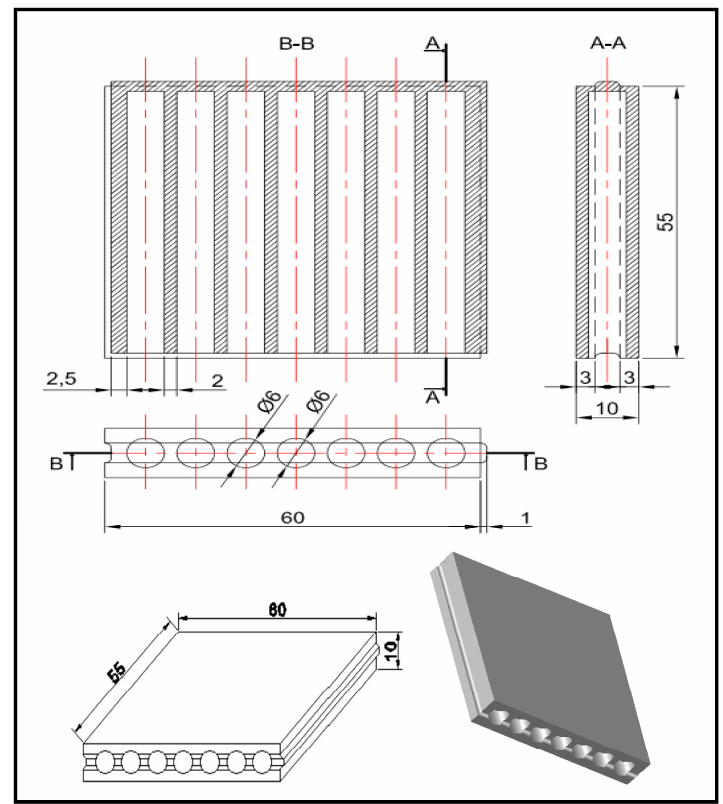
Figure 14. Perforated gypsum plaster blocks design.